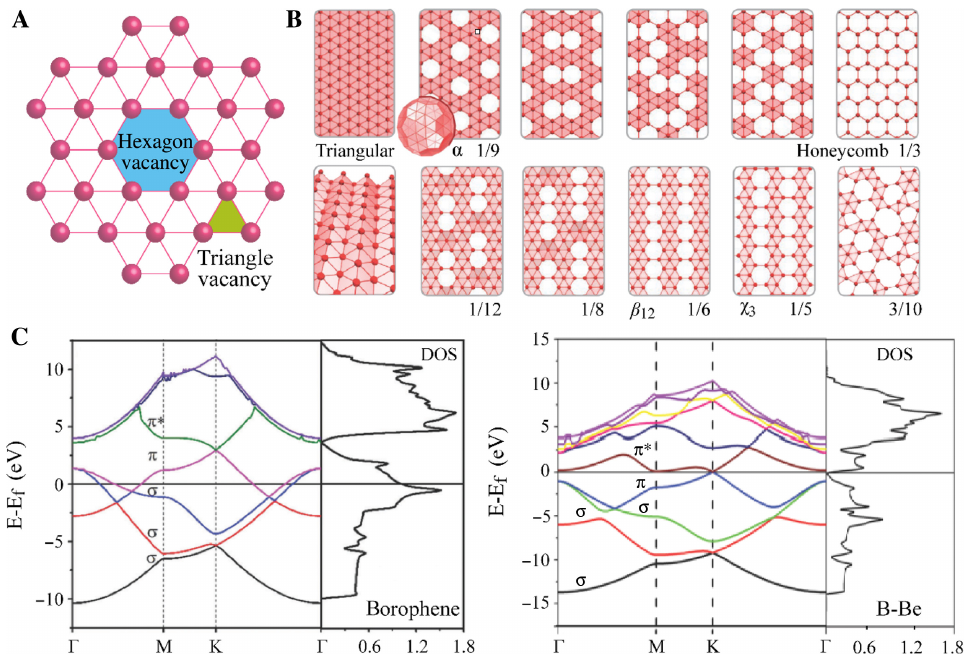
Figure 1: The geometric and electronic structures of borophene. (A) Schematic diagram of the basic structure of borophene consisting of hexagon and triangle vacancies. (B) Some typical structural configurations of free-standing borophene. The numbers at the bottom right of each panel indicate the structural parameter η . Reproduced with permission [50]. Copyright 2016, Springer Nature. (C) The comparison of the band structure and total density of states (DOS) of pristine borophene and Be-decorated borophene. Reproduced with permission [51]. Copyright 2019, The Royal Society of